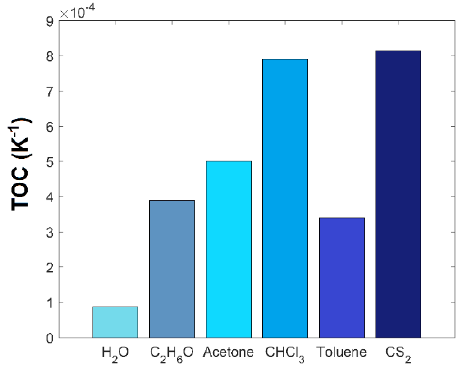
Figure 2. The magnitude of the thermo-optic coefficient of different liquids close to the operation wavelengths. H 2 O is water, C 2 H 6 O is ethanol, CHCl 3 is chloroform, and CS 2 is carbon disulfide.